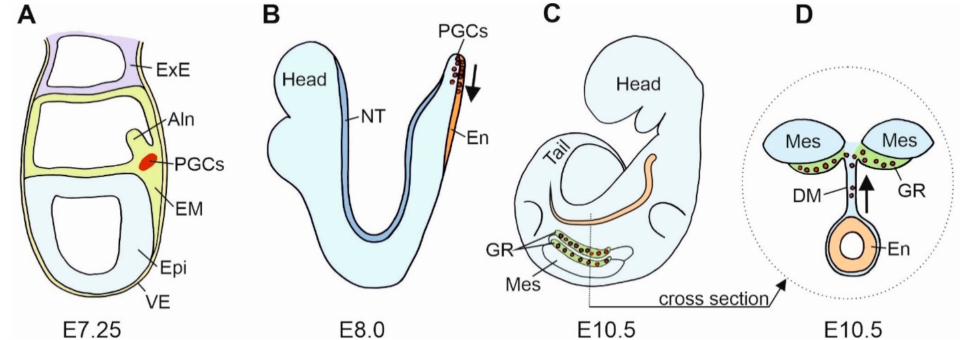
Figure 2. Scheme of the mouse primordial germ cells (PGCs) fate. ( A ). In the mouse gastrula at E7.25, E-cadherin positive ( + ) PGCs are present at the site of their origin, the E-cadherin positive embryonic mesoderm (EM). At this stage, mesodermal cells segregate into a group of E-cadherin positive somatic cells, E-cadherin positive PGCs, and E-cadherin negative ( − ) cells that form the allantois (Aln). ( B ). In the mouse neurula at E8.0, PGCs translocate from the mesoderm to the E-cadherin positive endoderm, En (a region of hindgut formation). At this stage, the expression of E-cadherin in PGCs decreases. Subsequently, PGCs migrate individually in the anterior direction. ( C ) (lateral view) and ( D ) (cross section) . In the mouse embryo at E10.5, PGCs leave the hindgut, increase E-cadherin expression and interconnect by filopodia. PGCs migrate dorsally through dorsal mesentery (DM) to the genital ridges (GR). Epi—epiblast; ExE—extraembryonic ectoderm; Mes—mesonephros; NT—neural tube; VE—visceral